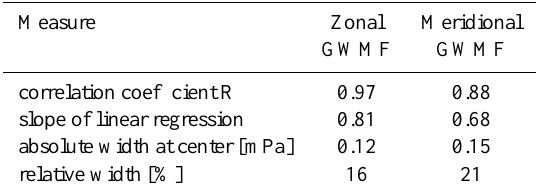
Table A1. Statistical measures from the correlation analysis be- tween GWMF from temperatures and winds for the zonal and meridional component. More than 100000 values were used for each of the statistical